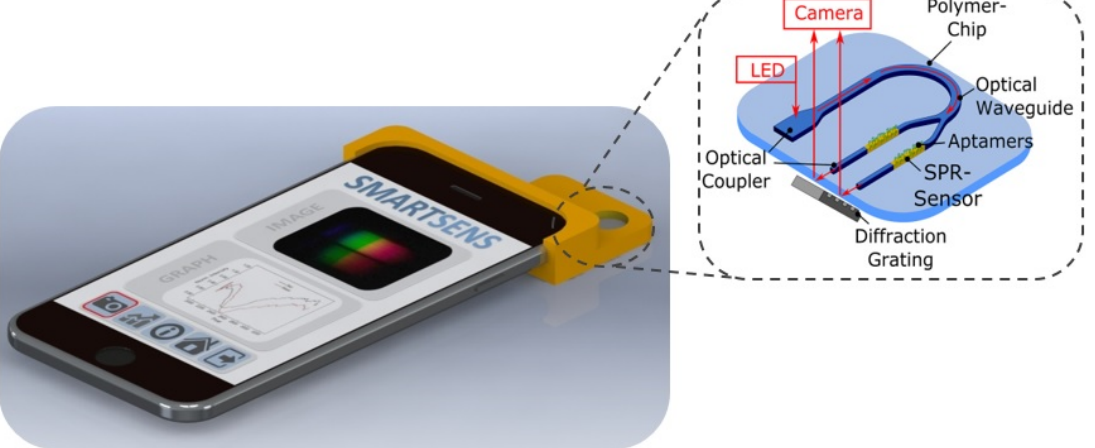
Figure 1. Conceptual design of the all-optical planar polymer-based biochip sensor platform for smartphones (SmartSens). As shown in the inset, a polymer chip containing planar-optical waveguides and Surface Plasmon Resonance (SPR) sensors can be interrogated using the flashlight LED and camera of a standard smartphone.